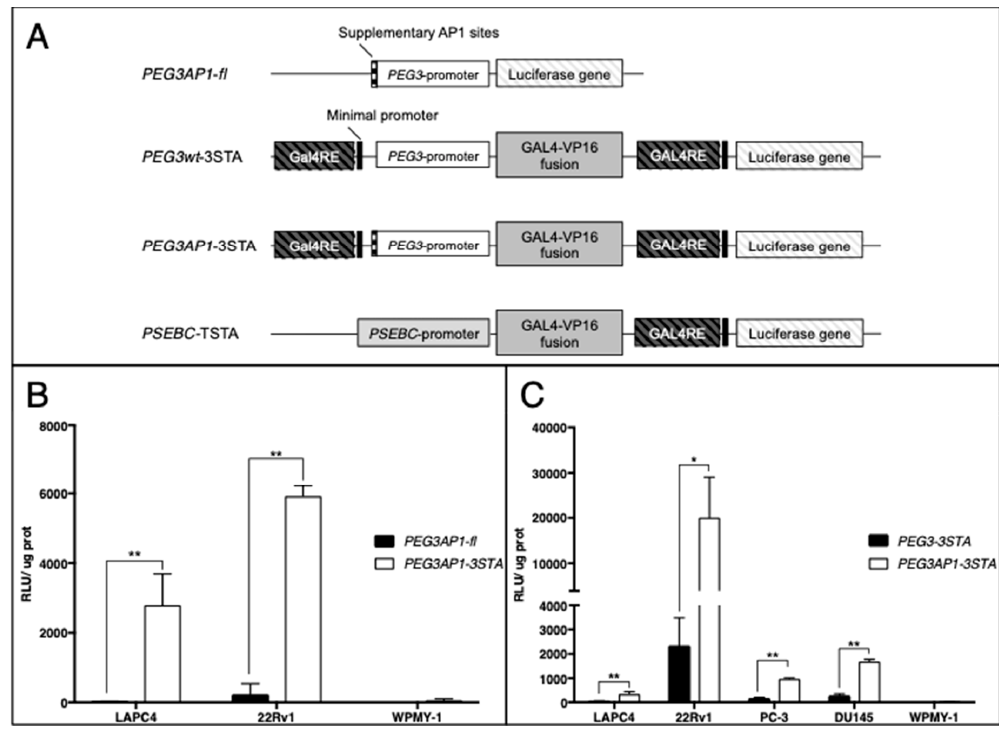
Figure 1. Transcriptional activity of modified progression elevated gene-3 (PEG3) promoter constructs. ( A ) Scheme of non-replicative reporter adenoviral constructs. ( B ) Amplification of PEG3AP1 promoter by means of the 3STA system. LAPC4 (prostate cancer (PCa)), 22Rv1 (PCa), and WPMY-1 (normal human fibroblastic prostate) cells were transduced with either PEG3AP1 -fl or PEG3AP1 -3STA adenovirus at 5 MOI for 72 h. Firefly luciferase (fl) activity was then assayed. The relative luciferase activity was normalized by protein content in each well. Data represent triplicate ± SD. ( C ) Impact of supplementary AP1 sites in PEG3 promoter. LAPC4, 22Rv1, PC-3, DU145 (all PCa), and WPMY-1 (normal human fibroblastic prostate) cells were transduced with either PEG3 -3STA or PEG3AP1 -3STA adenovirus at 5 MOI for 72 h. Firefly luciferase activity was then assayed. The relative luciferase activity was normalized by protein content in each well. Data represent triplicate ± SD, * p < 0.05, ** p < 0.01.